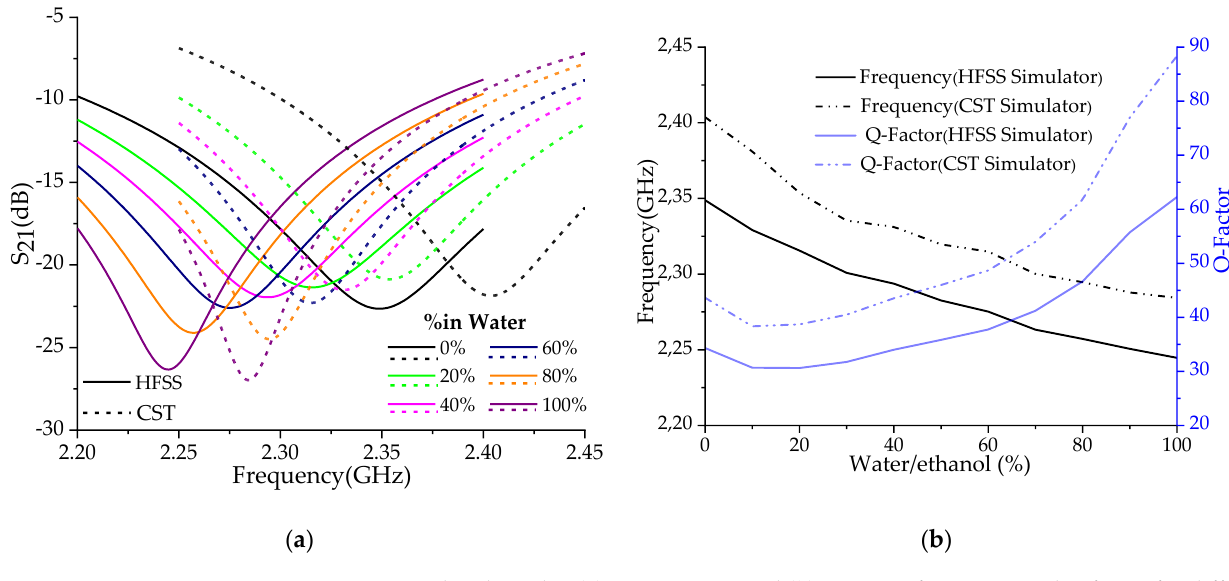
Figure 9. Simulated results: ( a ) S 21 response and ( b ) resonant frequency and Q factor for different mixture water concentrations, with r = 0.75 mm. Similarly, as shown in Figure 10, the sensitivity increased almost 2.5-fold compared to the case with r = 0.75 mm, while the quality factor (which has a direct link with the imaginary component of the permittivity) decreased by 15%. The CST and HFSS results curves almost overlap. The resonant frequency of this case decreased, averaging 2.2 GHz.